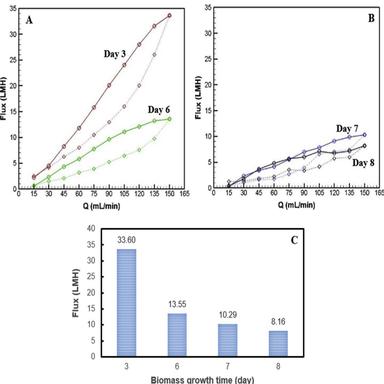
Permeate flux produced at various feed flow rate applied on the biofilm/filtration system at different growth time under compression (solid line)/decompression (dotted line) processes (A, B) and highest flux produced over time at Q = 150 mL/min (C).